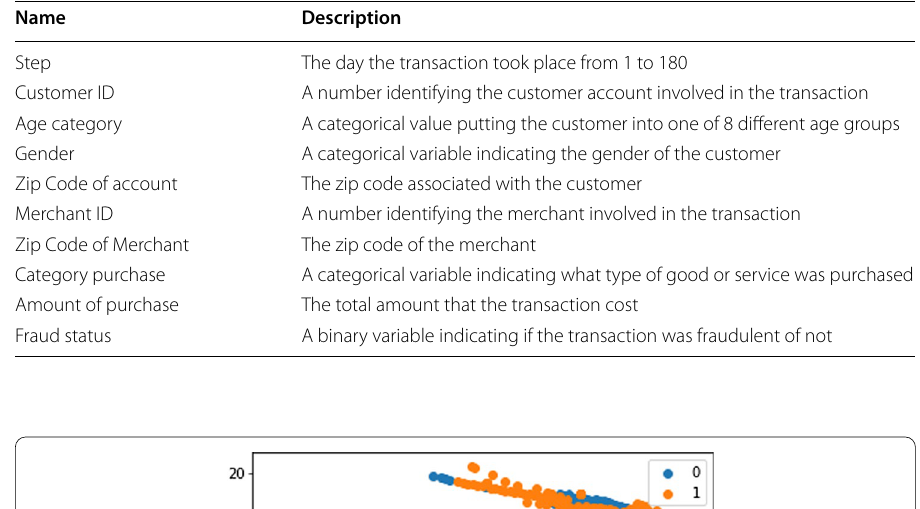
Table 2 Attributes of Dataset-2